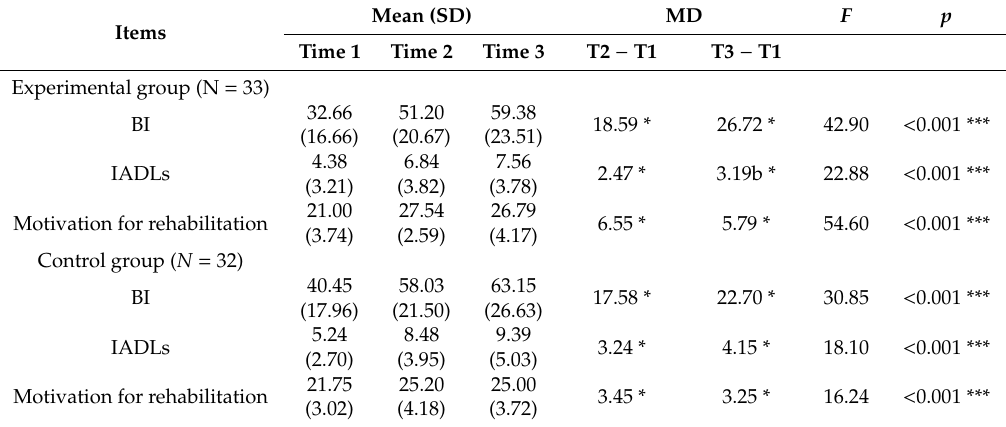
Table 2. Di ff erences in the e ff ectiveness of the interventions with regard to the BI, IADLs, and rehabilitation motivation scores among the stroke patients in the experimental and control groups at di ff erent testing times ( N = 65).